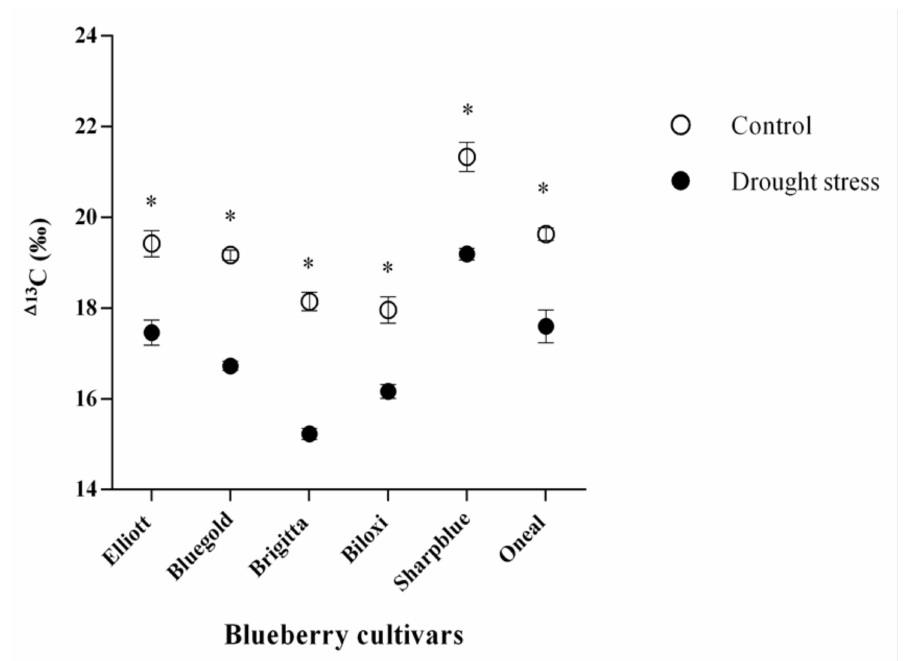
Figure 2. Isotopic discrimination of 13 C ( ∆ 13 C) of blueberry cultivars after 6 weeks of drought stress. White circles indicate control plants (watered with 300 mL) and black circles indicate plants under drought stress (watered with 150 mL). Standard error bars are shown. * Indicate significant statistical di ff erences between treatments for each